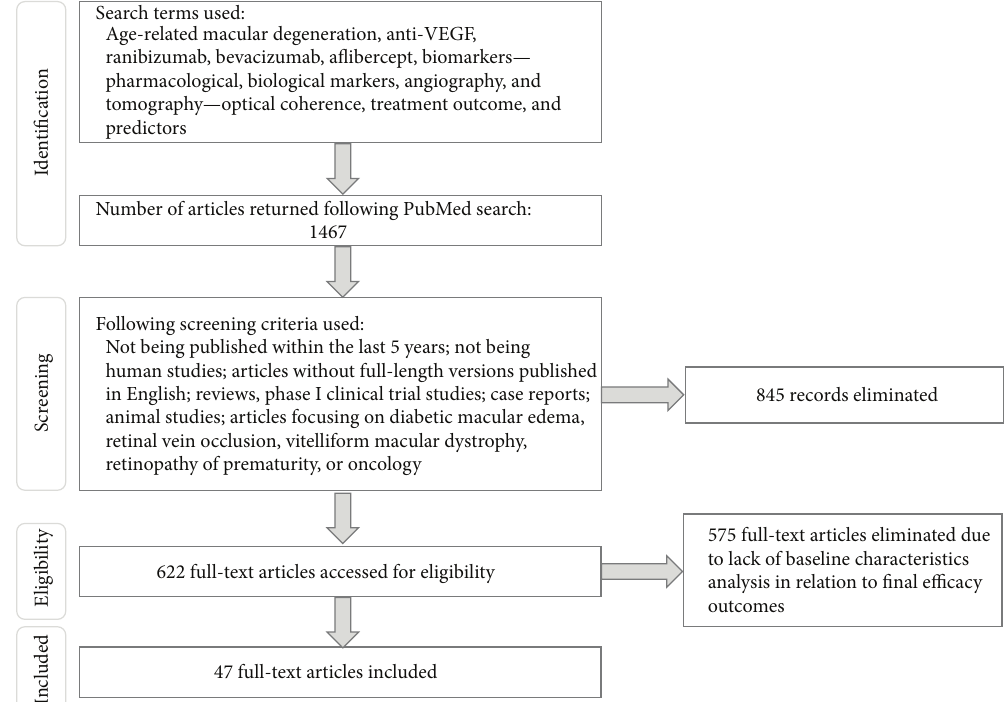
Figure 1: Literature search